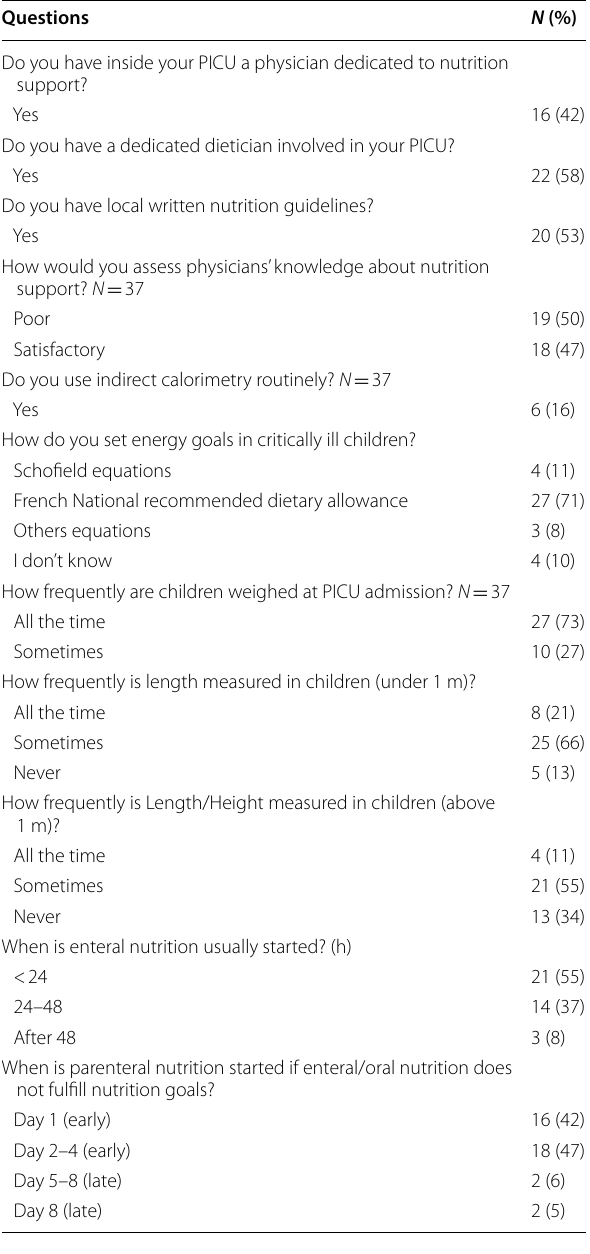
Table 1 Physicians’ answers to key nutrition